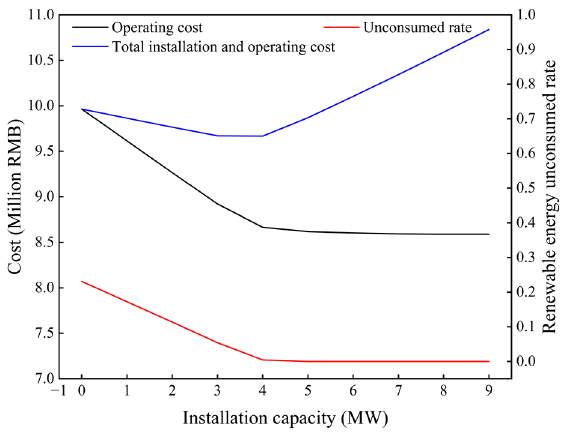
Figure 13. Cost and consumption of PIES 1 with different P2G capacities installed in Scenario 4.